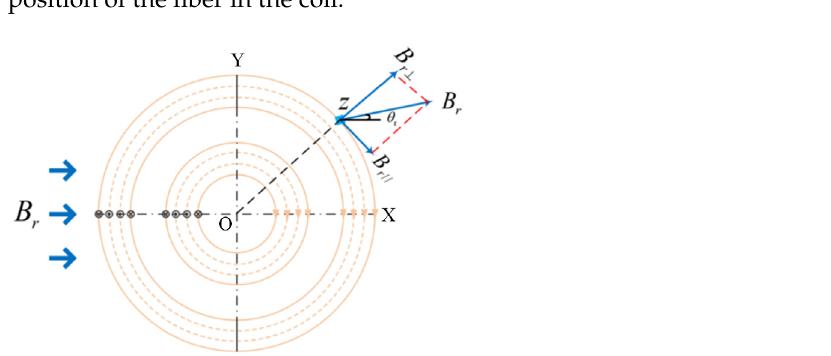
Figure 2. Schematic diagram of the radial magnetic field acting on the fiber coil. In which z indicates the length of the fiber.